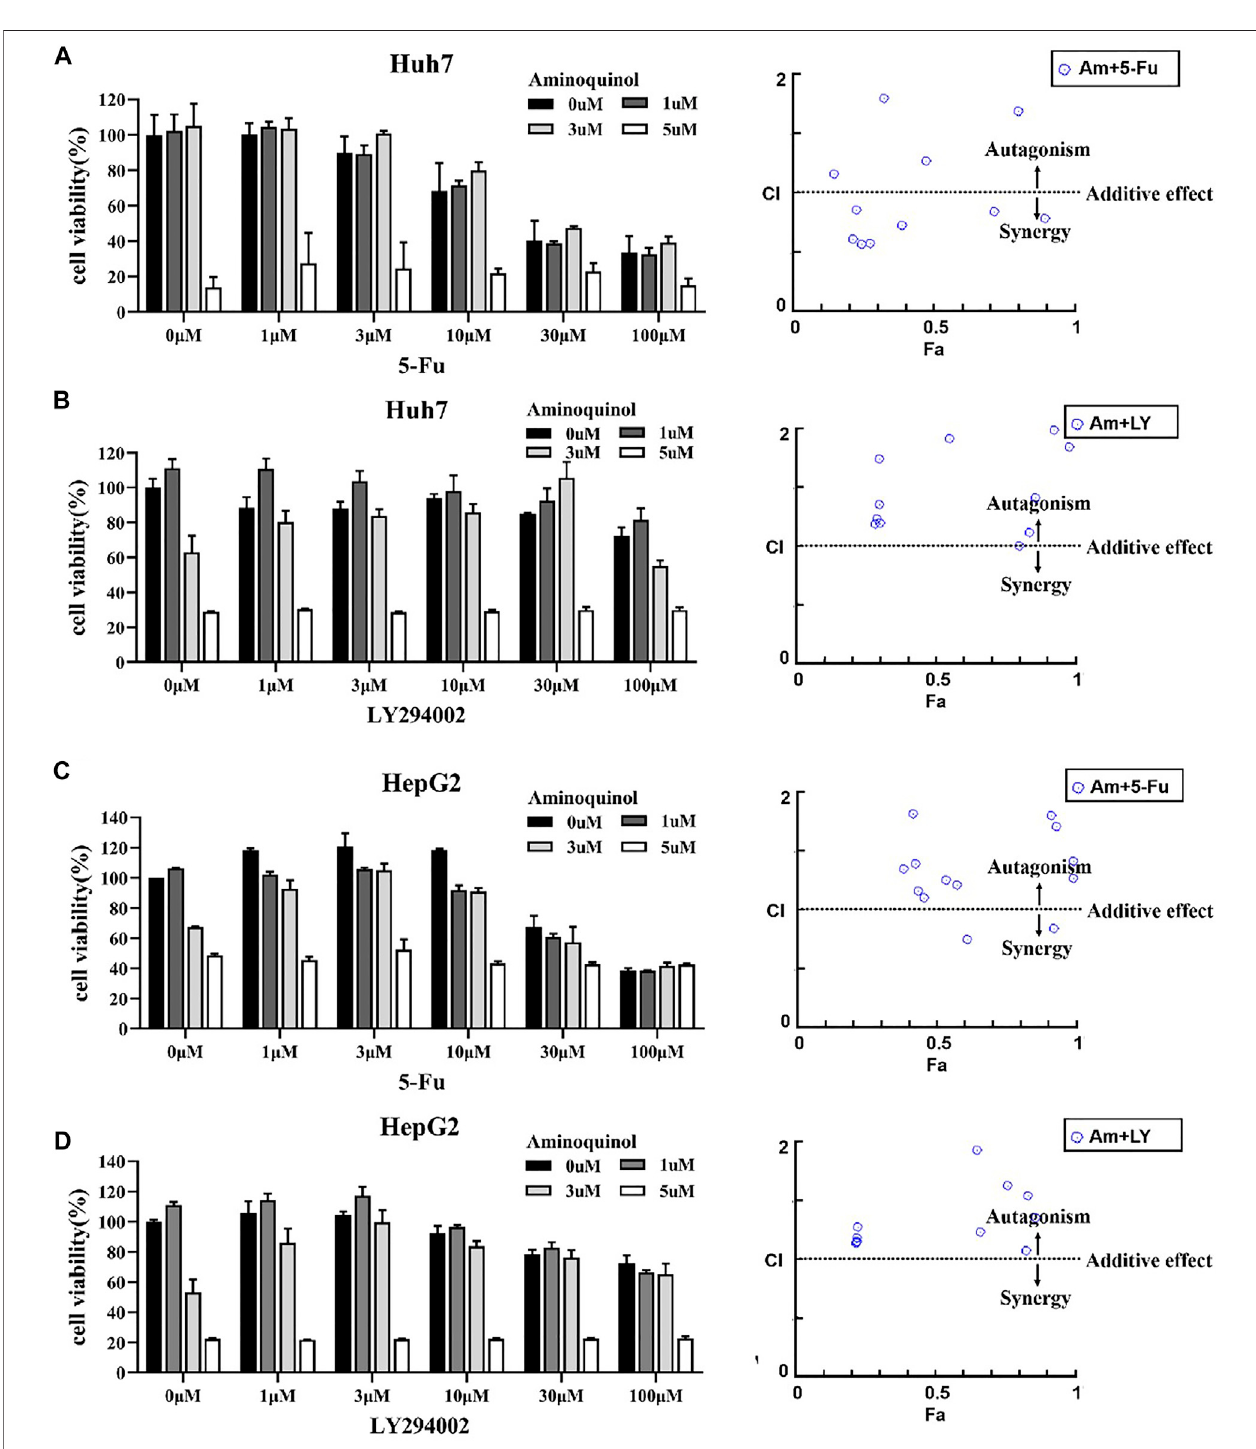
FIGURE 4 | The antagonistic or synergistic effect of combinating aminoquinol with 5-Fu, sorfafenib, and LY294002 in reducing cell viability in HCC cells (A, B) , left fi gures)Huh7cellsor (C,D) ,left fi gures)HepG2cellsweretreatedfor72 hwithaminoquinol(0,1,3,5 μ M)incombinationwith5-Fu(0,1,3,10,30,100 μ M),orthePI3K inhibitor LY294002 (0, 1, 3, 10, 30, 100 μ M), and cell viability determined (A – D) , right fi gures) The fraction affected (Fa)-combination index (CI) plots of aminoquinol in combination with 5-Fu or LY294002. The combined effects and the speci fi c combination index (CI) were analyzed by CompuSyn software. CI > 1 indicated the antagonistic effect, CI (cid:2) 1 indicated additive effect, and CI < 1 indicated synergistic effect.